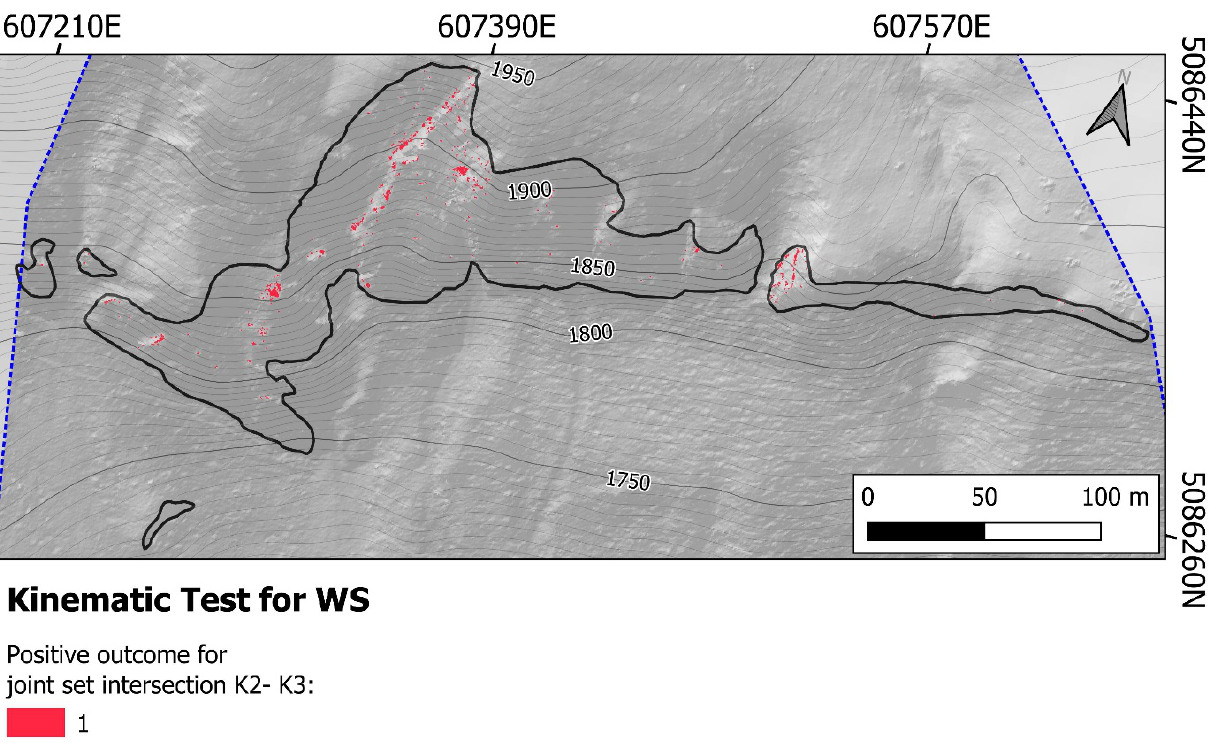
Figure A8. Image of the partial output file showing the kinematic test for WS performed considering only the intersection between joint set K2 and K3.